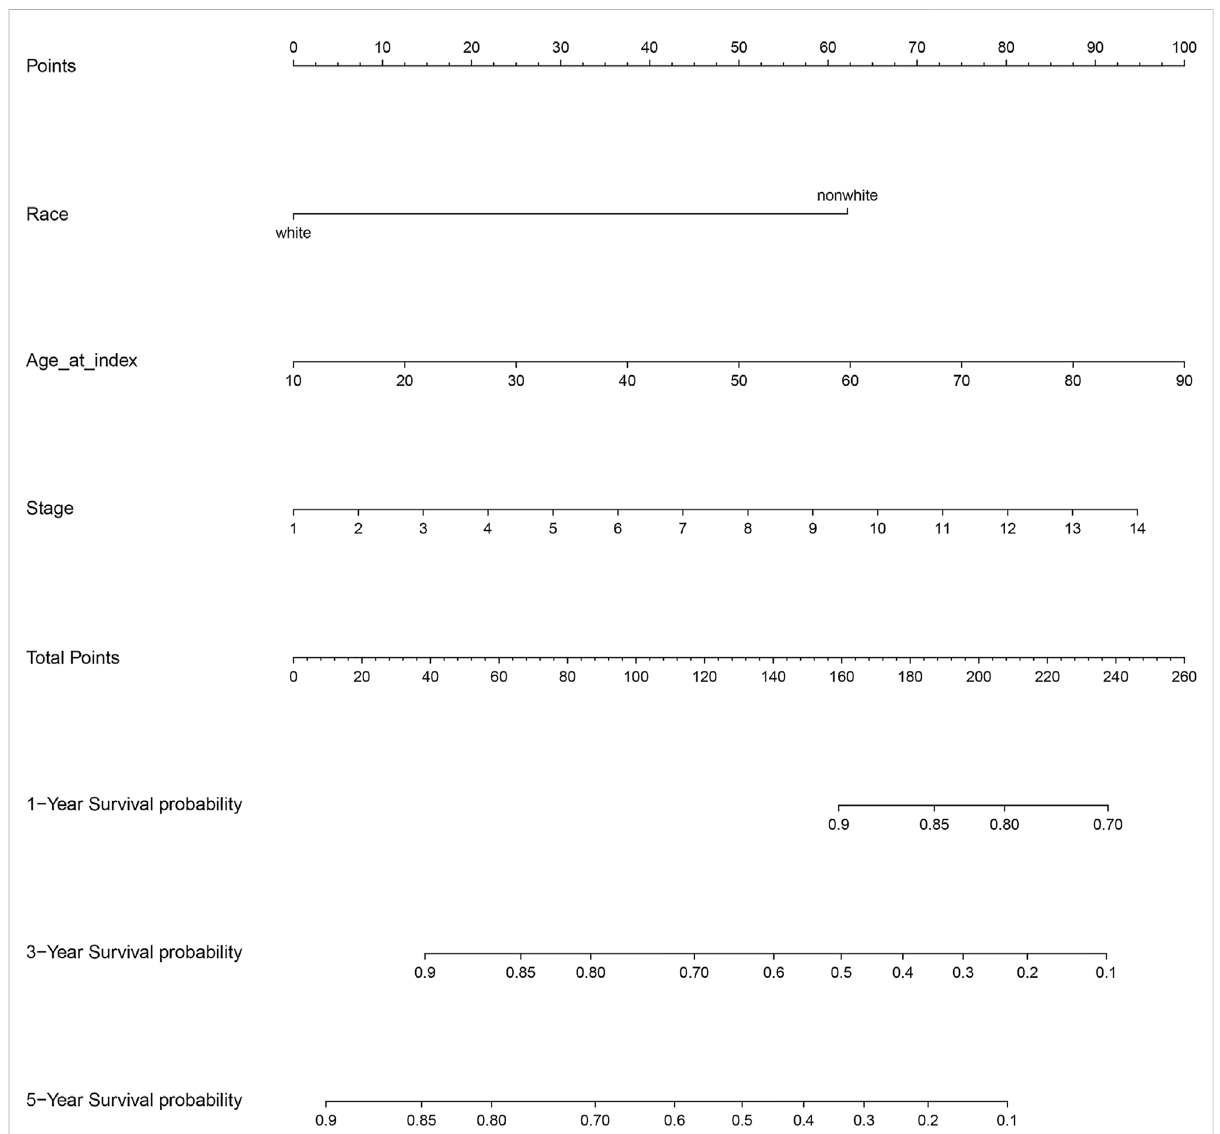
FIGURE 4 Nomogramfortherelationshipbetweenclinicaldataandriskscore.Stage1forI/IInos,2for0,3forI,4forIa,5forIb,6forII,7forIIa,8forIIb, 9 for II c, 10 for III, 11 for III a, 12 for III b, 13 for III c, and 14 for